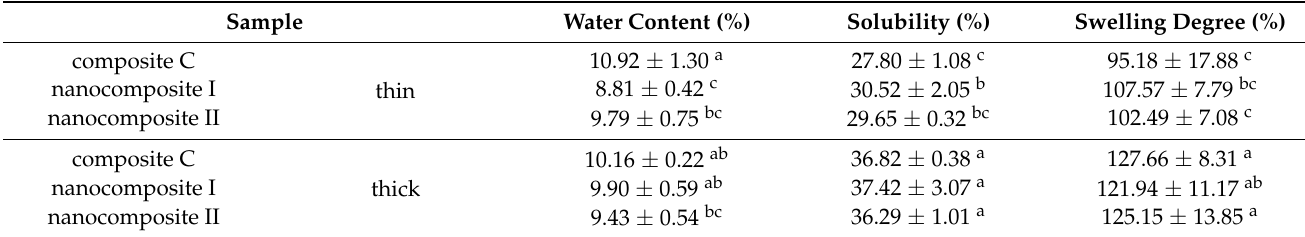
Table 7. Mechanical properties of